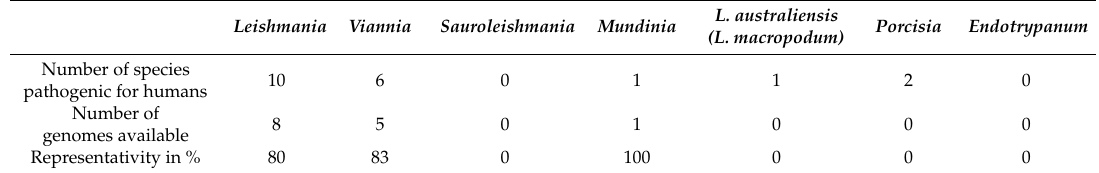
Table 1. Representativity of sequenced genomes available in relation to the number of known Leishmania species that are pathogenic for humans, according the updated classification of Akhoundi et al. (2017) [18]. L. australiensis Porcisia Endotrypanum Leishmania Viannia Sauroleishmania Mundinia (L. macropodum) Number of species 10 6 0 1 1 2 pathogenic for humans